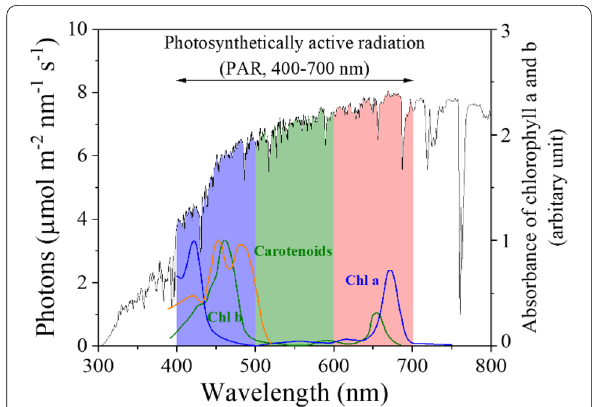
Fig. 1 Solar spectral irradiance and absorption spectra of chlorophylls a and b and carotenoids, reproduced with permissions from [33] and [34],